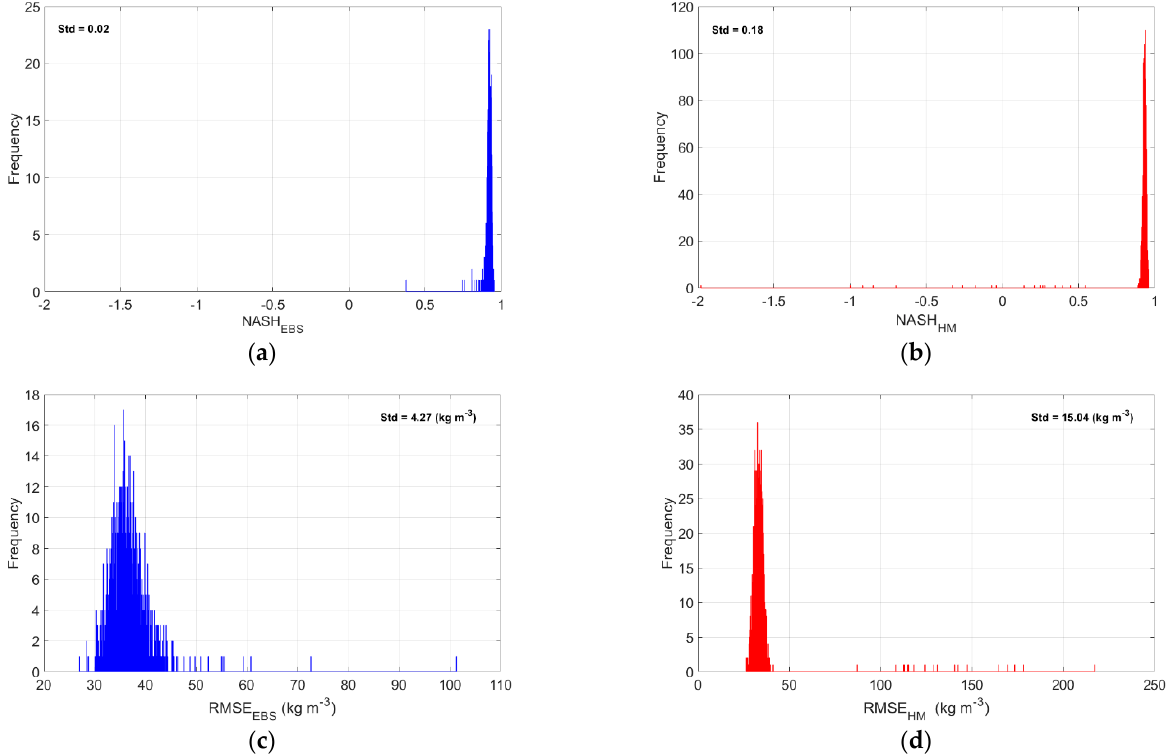
Figure 8. Histograms showing the robustness test between EBS and HM: ( a ) standard deviation (NASH EBS ) = 0.02, ( b ) standard deviation (NAS HHM ) = 0.18, ( c ) standard deviation (RMSE EBS ) = 4.27 kg m − 3 , ( d ) standard deviation (RMSE HM ) = 16.04 kg m − 3